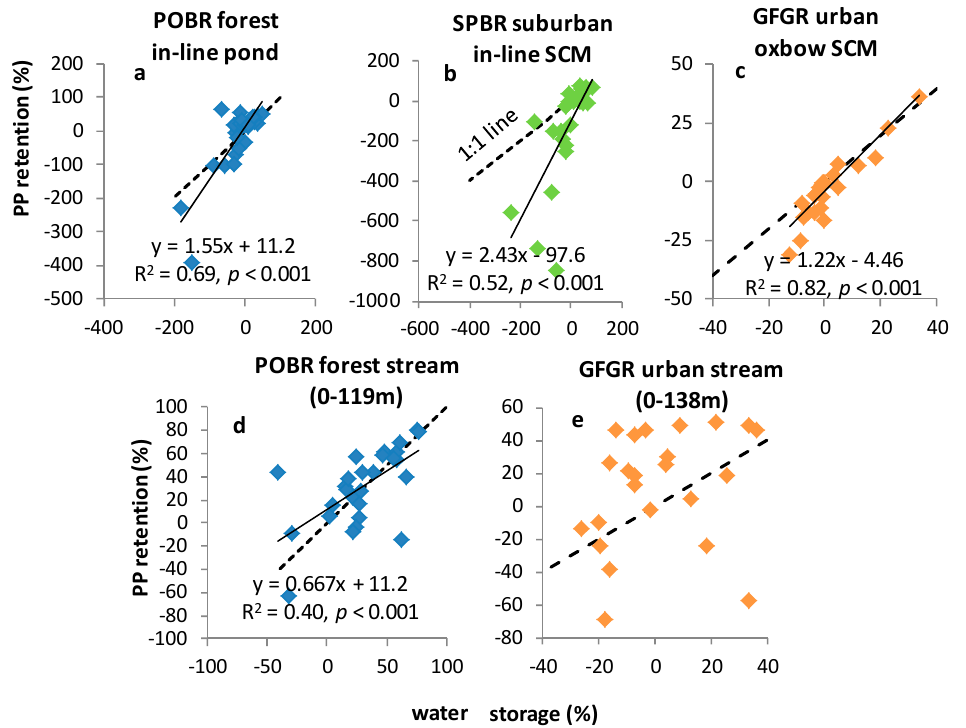
Figure 6. Linear regression of particulate phosphorus (PP) retention efficiency with percent stream water storage in ( a )–( c ) the three pond/SCMs and ( d )–( e ) two free ‐ flowing stream reaches (POBR 0–119 m and GFGR 0–138 m). A 1:1 line was added to each panel to show the deviation of PP from stream water mass balance. The slopes of the regression lines were all >1 and the values were generally below 1:1 line, indicating larger PP release relative stream water storage.